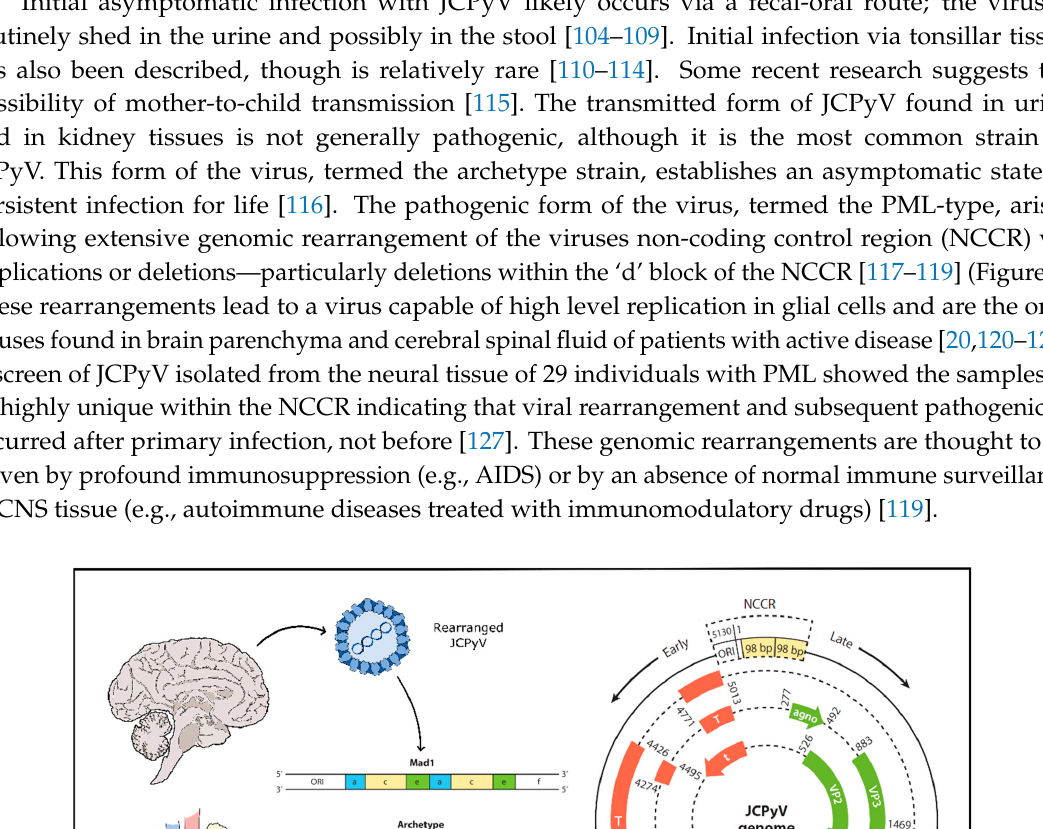
Adapted from [30] and